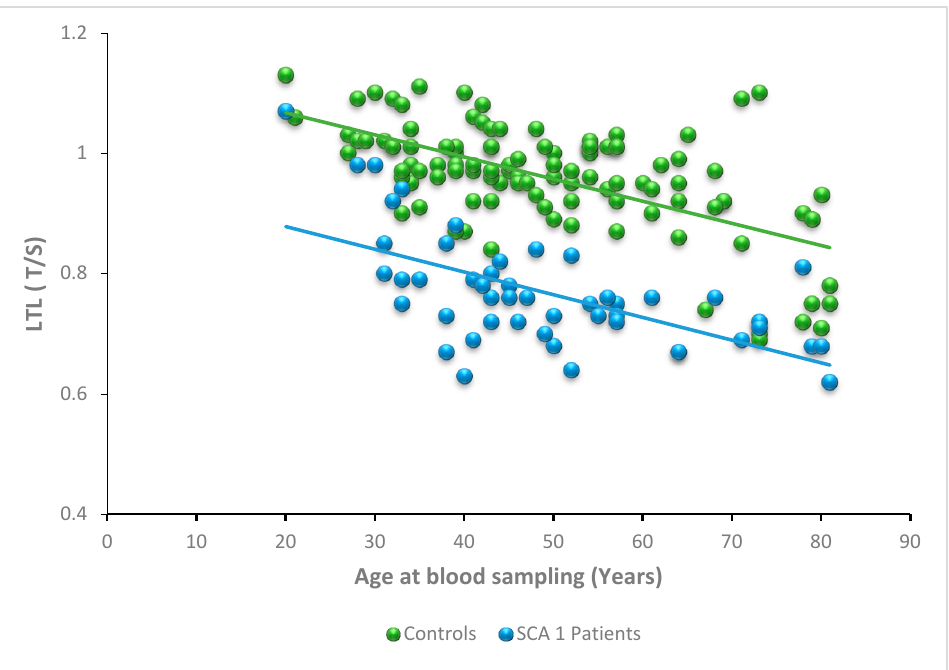
Figure 2. Relationship between LTL and age at blood sampling in SCA1 patients. LTL expressed as a relative telomere length T/S ratio as a function of age at blood sampling in SCA1 patients (n = 52; blue spheres) and controls (n = 104; green spheres). The LTL values of SCA1 patients are lower than controls at any age, as shown by the elevation of the regression lines ( p < 0.0001). However, the slopes are similar ( p = 0.88).